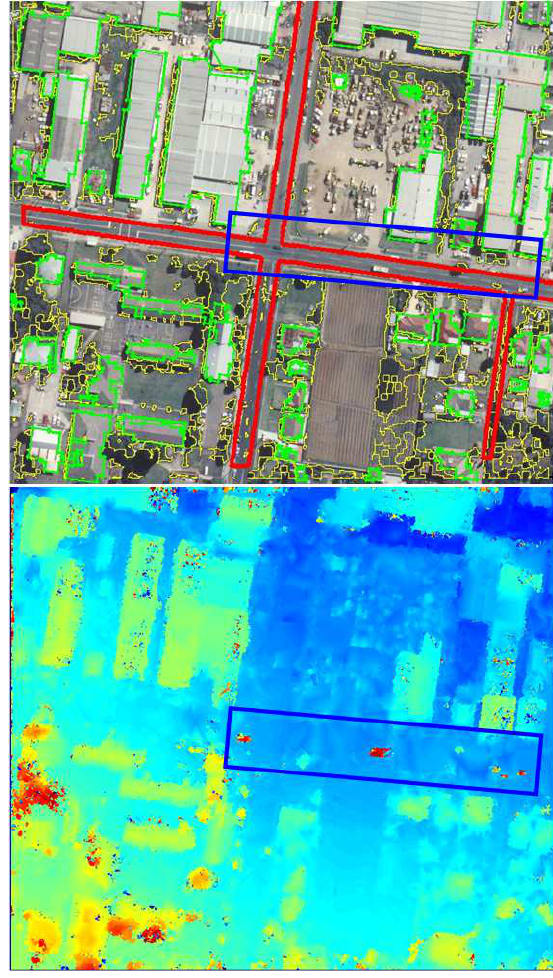
Figure 3: Top: Reference image with with building outlines (green), vegetation areas (yellow) obtained by our method as well as streets outlines (red) provided by means of the GIS for the data set Fairfield . Bottom: the corresponding DSM computed from three images without laser points. The moving objects, which end up as outliers in the depth map, are surrounded by the blue rectangle.